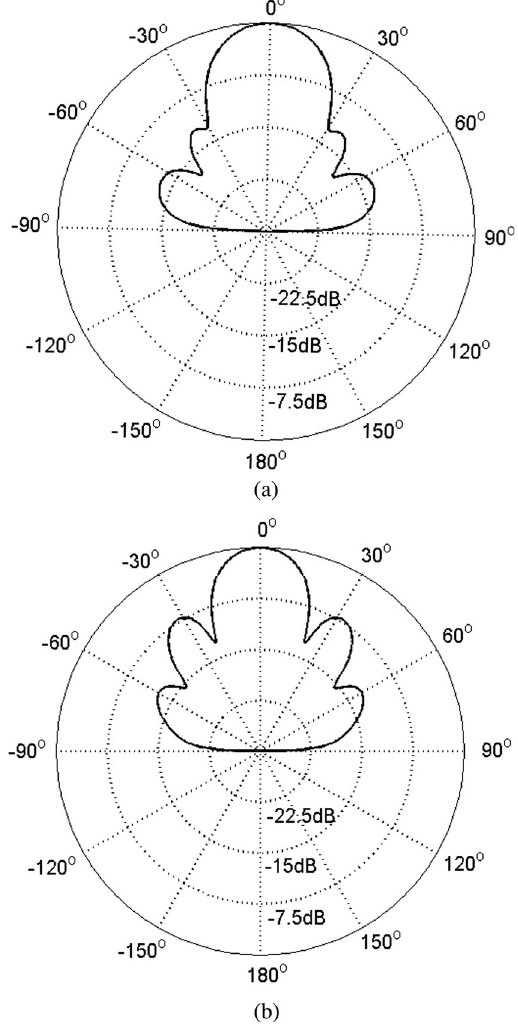
FIG. 11. Radiation patterns of (a) Dolph-Tschebyscheff and (b) uniform arrays. Both arrays normally reflect the incident plane wave.